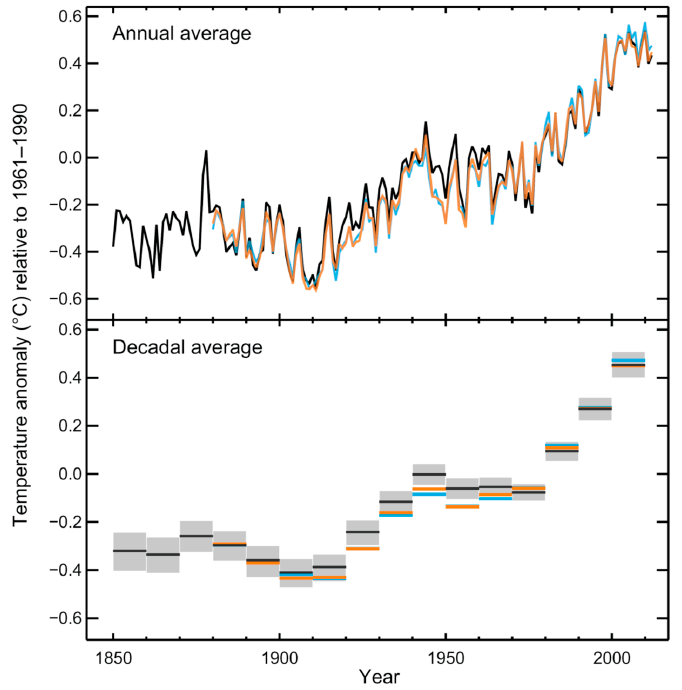
Figure 3. Irregularity observed in the world average temperatures on the surface, land and oceans combined between 1850 and 2012 (Reproduced with permission from The Intergovernmental Panel on Climate Change, IPCC, 2013: Summary for Policymakers. In: Climate Change 2013: The Physical Science Basis. Contribution of Working Group I to the Fifth Assessment Report of the Intergovernmental Panel on Climate Change ; Figure SPM.1 (a) Observed global mean combined land and ocean surface temperature anomalies, from 1850 to 2012 from three data sets. annual mean values. published by Cambridge University Press